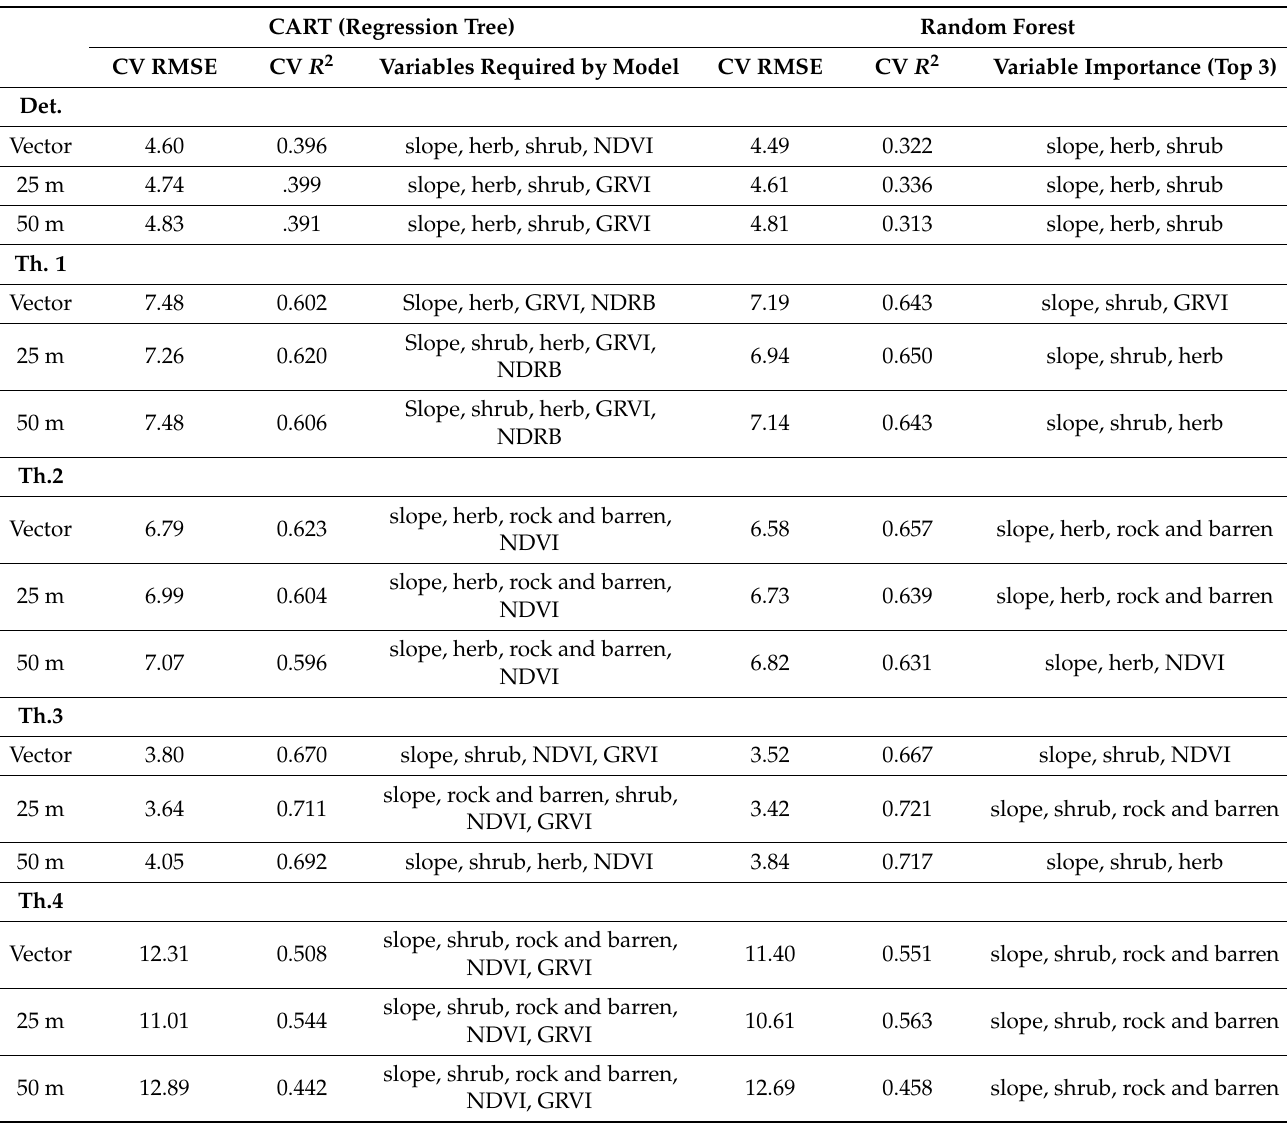
Table 5. Machine learning model diagnostics. Cross validation (CV) statistics are leave-one- out